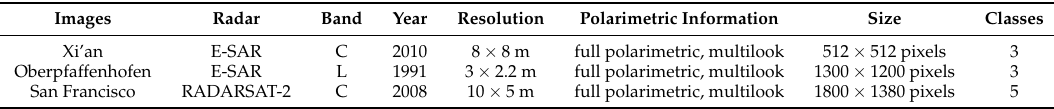
Table 1. Information about Three PolSAR Images.